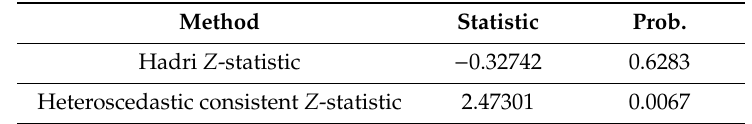
Table 5. Hadri Unit Root